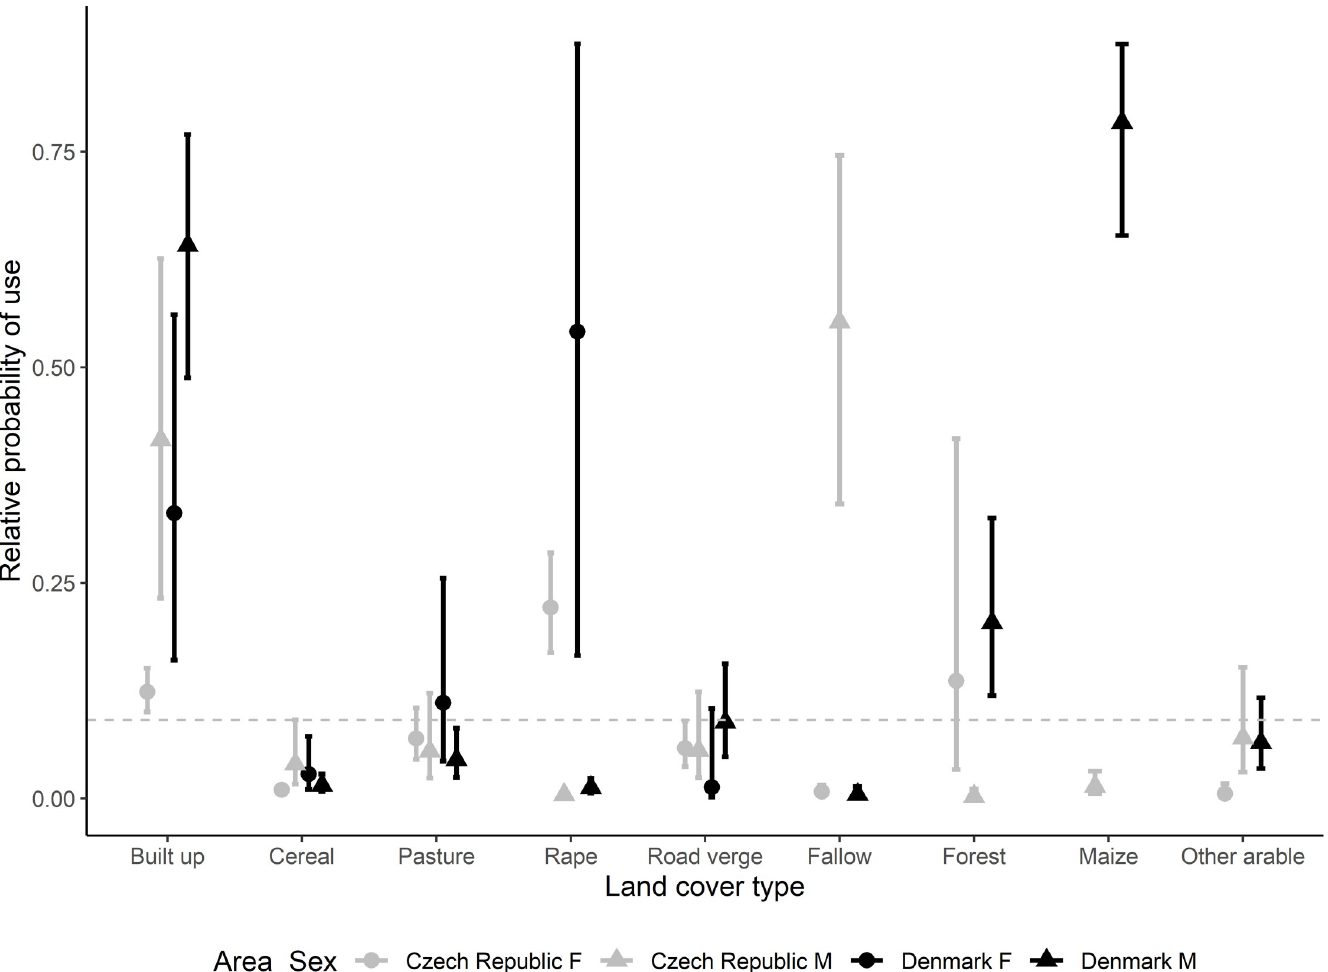
Fig 5. The relative probability of use (as estimated by logistic resource selection functions) by Czech (grey) and Danish (black) little owls for the different land cover types. Females are represented with circles and males with triangles. Available positions were created using correlated random walks. Values > 0.1 (above the grey dashed line) indicate selection, whereas values < 0.1 indicate avoidance (for each used position we created 10 random positions). The 95% confidence intervals are given as bars.